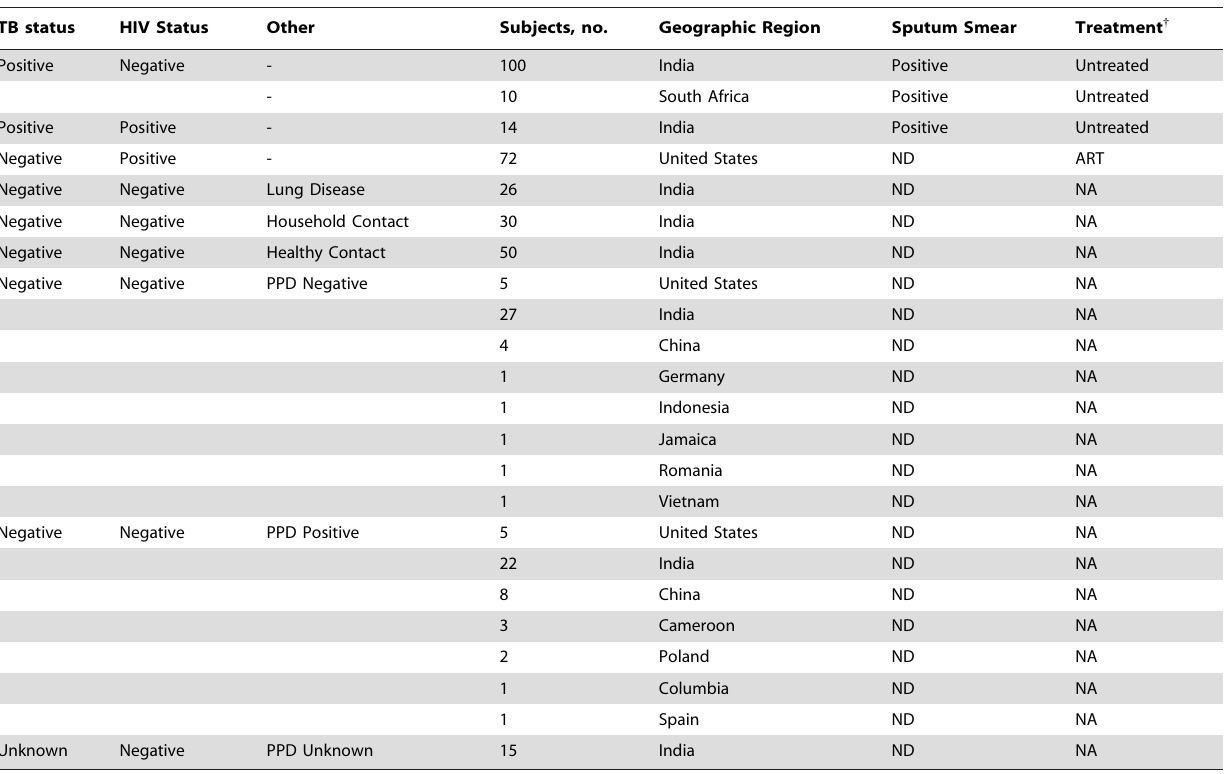
Table 1. Clinical characteristics of study